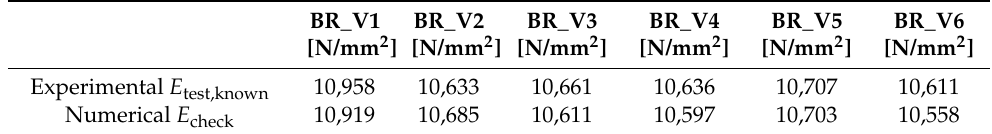
Table 3. Experimentally and numerically determined values E L,m,R,eff of bending test specimens with l s = 600 mm.